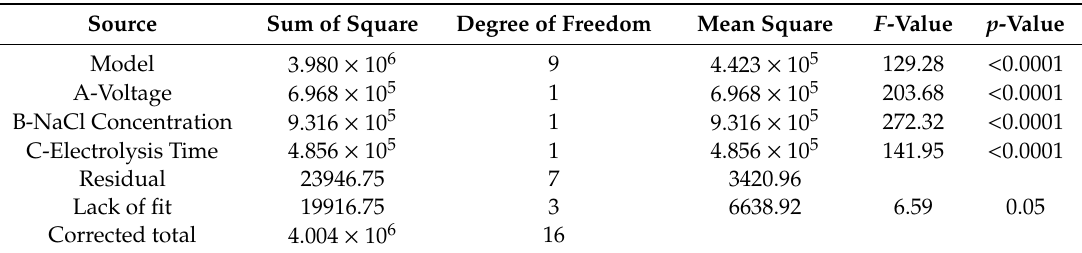
Table 12. Analysis of variance for the developed response surface quadratic model for ORP of